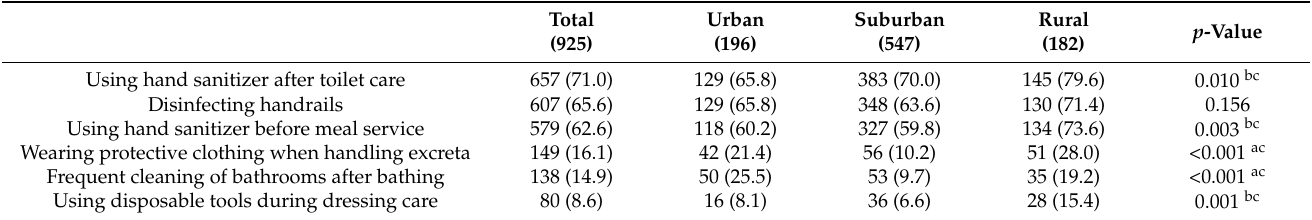
Table 4. Increased attention to infection control measures after the start of the pandemic (N, %)